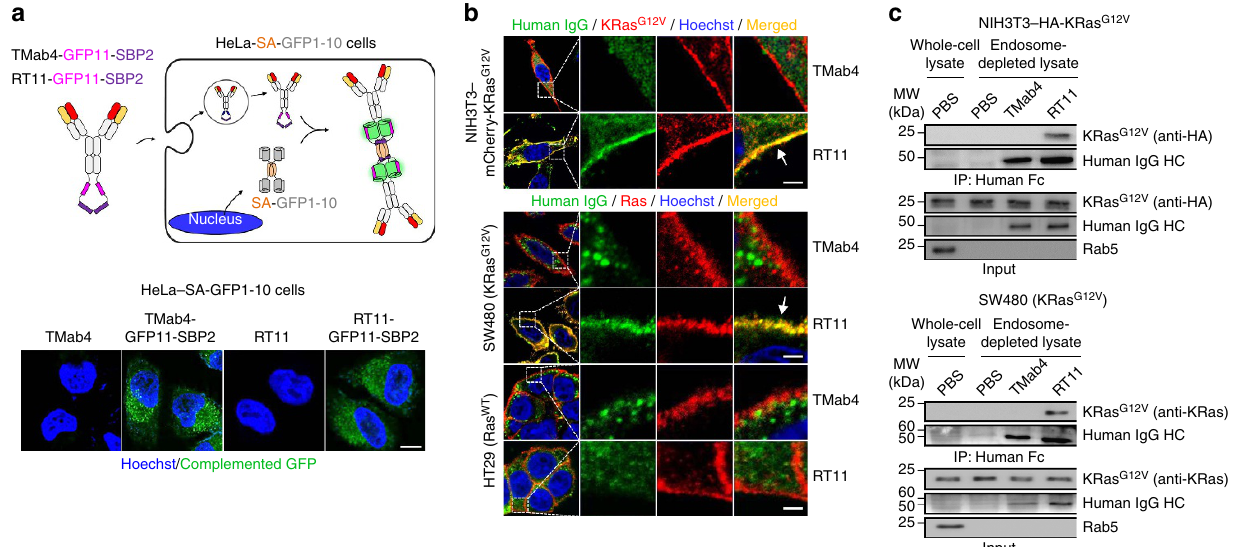
Figure 2 | RT11 internalizes into the cytosol and binds to active Ras mutant in living cells. ( a ) Cellular internalization and cytosol localization of GFP11- SBP2-fused RT11 and TMab4 antibodies, as assessed by confocal microscopy measuring complemented GFP signals (green) in HeLa-SA-GFP1-10 cells after treatment with 1 m M of the antibodies for 6h. Scale bar, 20 m m. ( b ) Cellular internalization and co-localization of RT11 (green), but not TMab4 (green), with the inner plasma membrane-anchored active Ras (red) in mCherry-KRas G12V -transformed NIH3T3 and KRas G12V -harbouring SW480 cells, analysed by confocal microscopy. The Ras WT -harbouring HT29 cells were also analysed as a control. The areas in the white boxes are shown at a higher magnification for better visualization. The arrow indicates the co-localization of RT11 with activated Ras. The cells were treated with 2 m M of antibody for 12h. Scale bar, 5 m m. In a , b , nuclei are counterstained with Hoechst33342 (blue). ( c ) Immunoprecipitation (IP) of KRas mutant with RT11, but not TMab4, from endosome-depleted cell lysates of HA-KRas G12V -transformed NIH3T3 and SW480 cells, treated with 2 m M of antibody for 12h before analysis. The endosome-depleted cell lysates were assessed by the absence of Rab5, an early endosome marker 24 . In a – c , images are representative of at least two independent